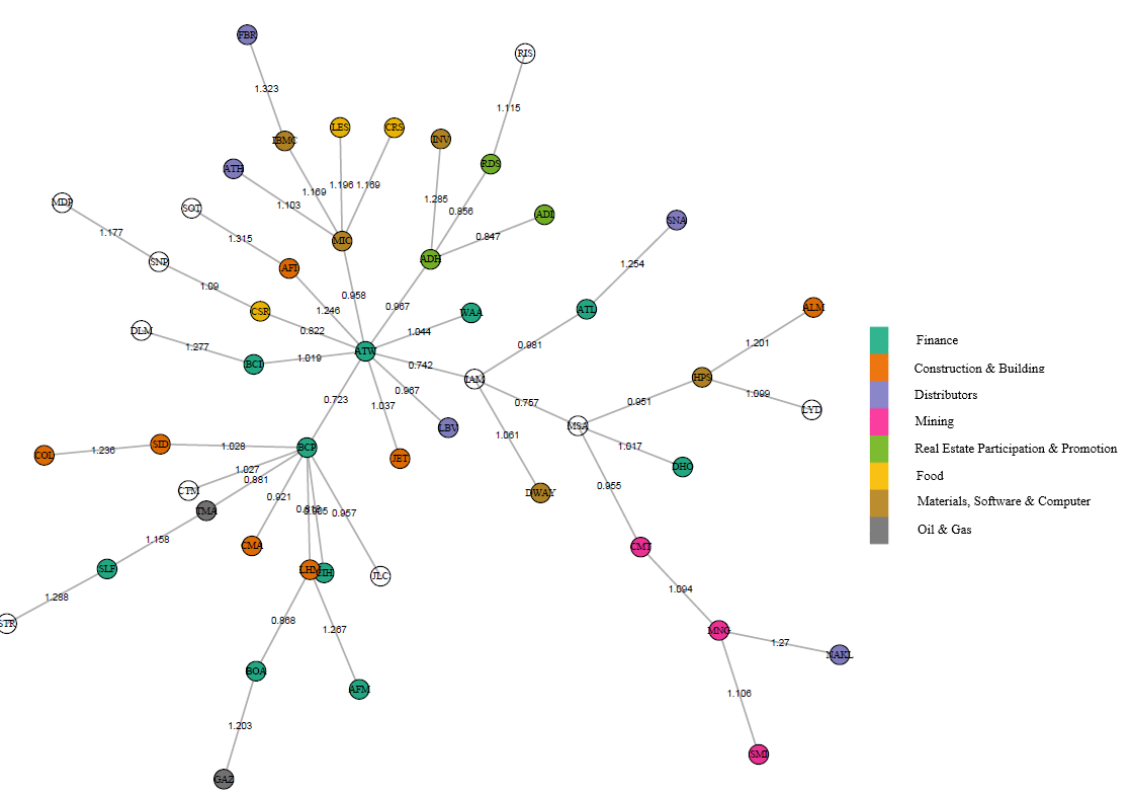
Figure 2. Crisis minimum spanning